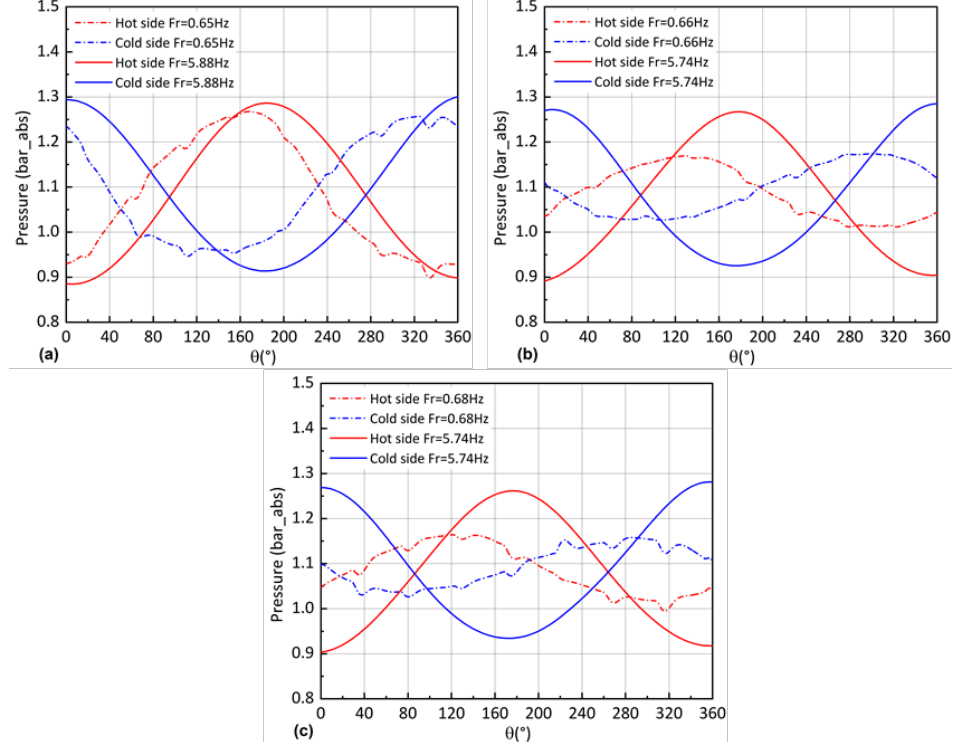
Figure 9. Evolution of pressures at hot and cold inlet sides of regenerator (( a ): Str_30%, ( b ): Str_35%, ( c ): Str_40%. L 1 = 60 mm, C 1 = 64.4 mm) versus phase for temperature gradient Δ T 1 = 70 °C/10 °C.